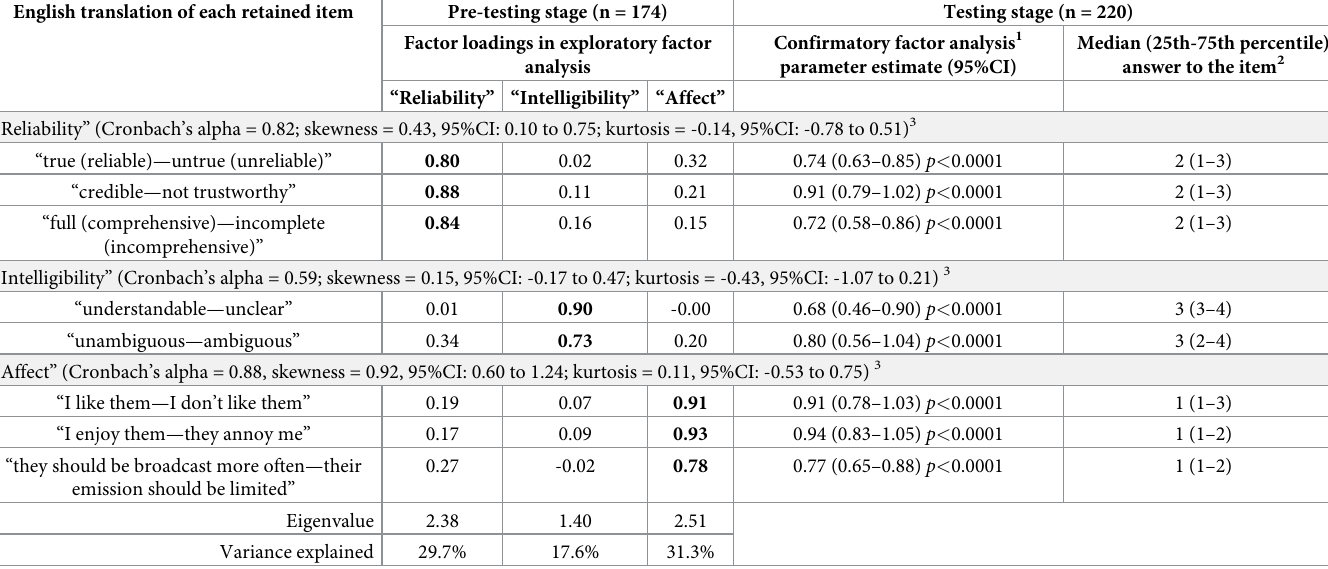
Table 3. Psychometric properties of the items in the trust in advertising dietary supplements (TiADS) questionnaire. English translation of each retained